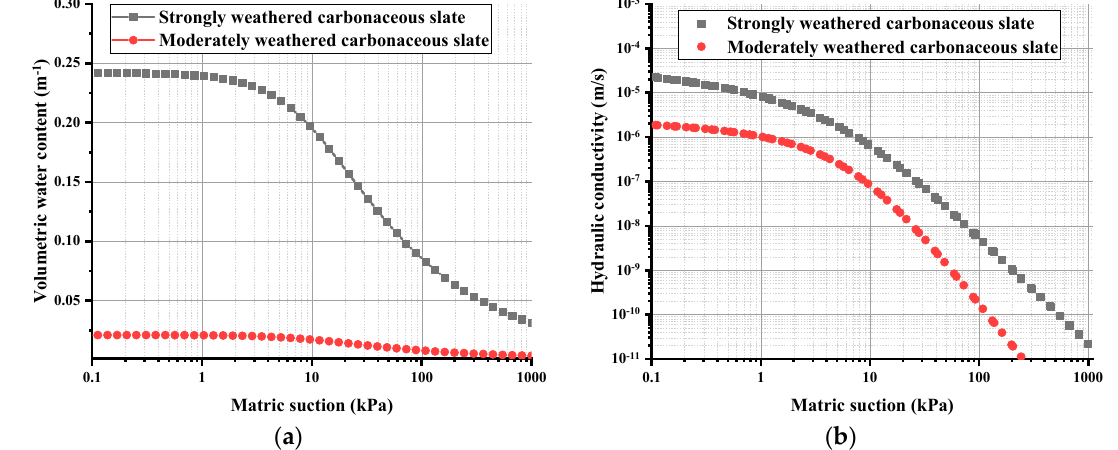
Figure 7. ( a ) Water retention curve; ( b ) Hydraulic conductivity curve.